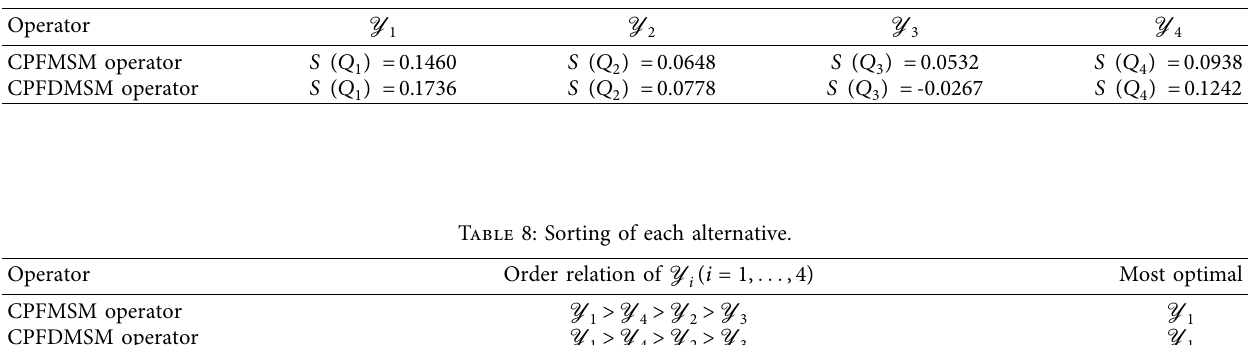
Table 7: Score index of all the alternatives of Y